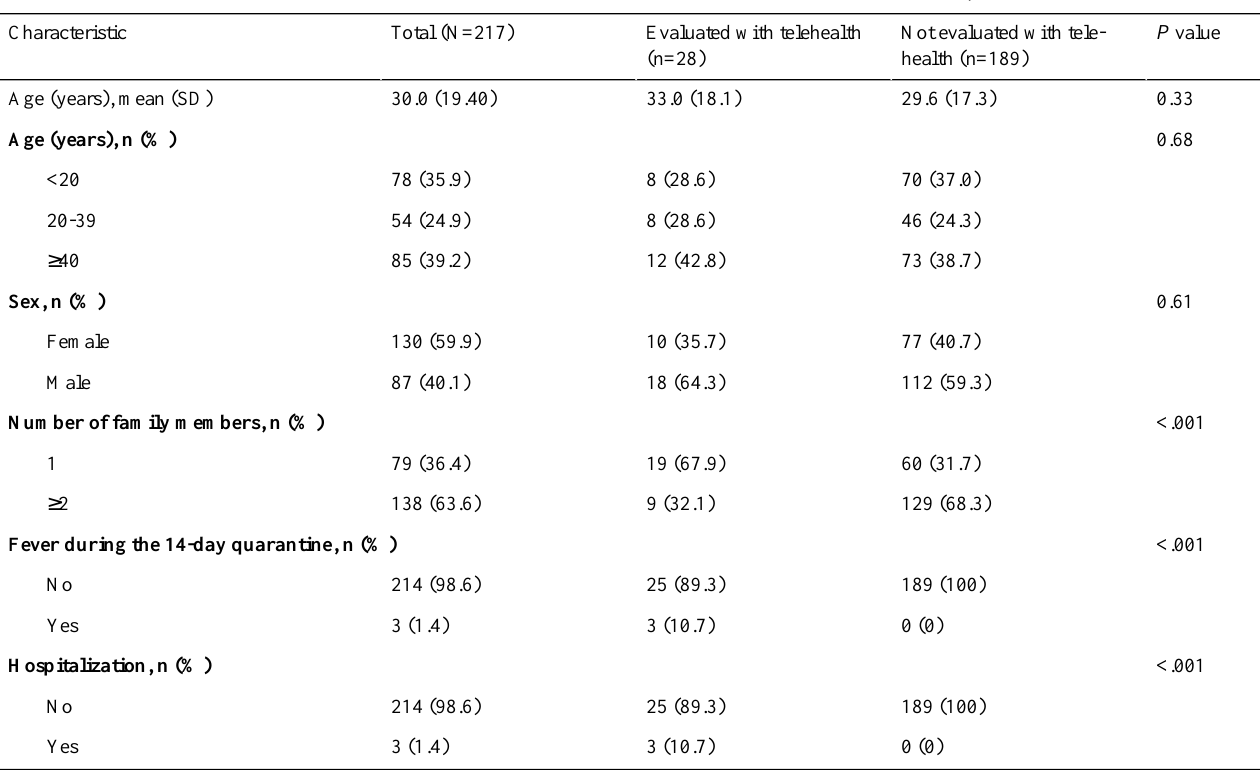
Table 1. Characteristics of Taiwanese travelers who were and were not evaluated with telehealth at a centralized quarantine center.